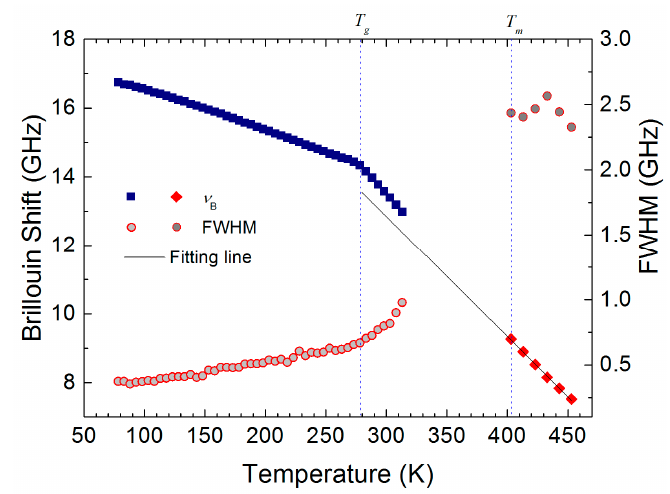
Figure 3. Temperature dependence of the Brillouin shift ( ν B ) and the full width at half maximum (FWHM, Γ B ). The solid line denotes the result of the linear fitting for ν B in the liquid phase. The two dotted lines show the glass transition temperature ( T g ) and the melting point ( T m ).